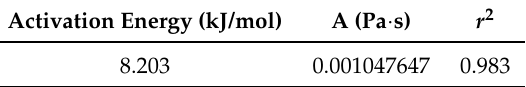
Table 4. Arrhenius equation fitting parameters.